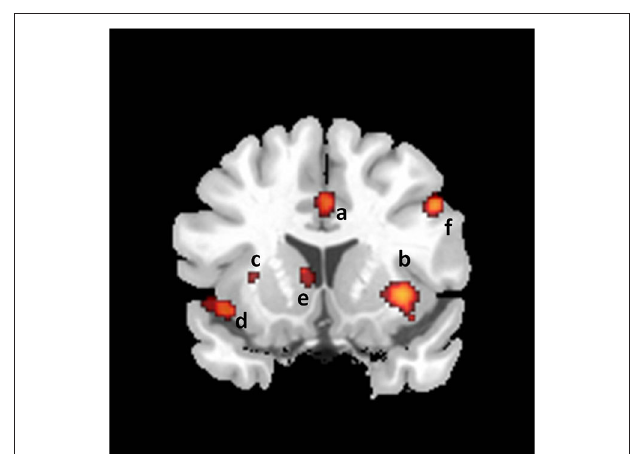
FIGURE 2 | Coronal section showing activations found in a meta-analysis of 21 studies of brain responses of heterosexual men to sexual stimuli (unpublished figure from study by Stoléru et al., 2012) . Section is located 1 mm caudal to anterior commissure. a, a’: insula; b, b’: amygdala; c: hypothalamus. Right is to the right.